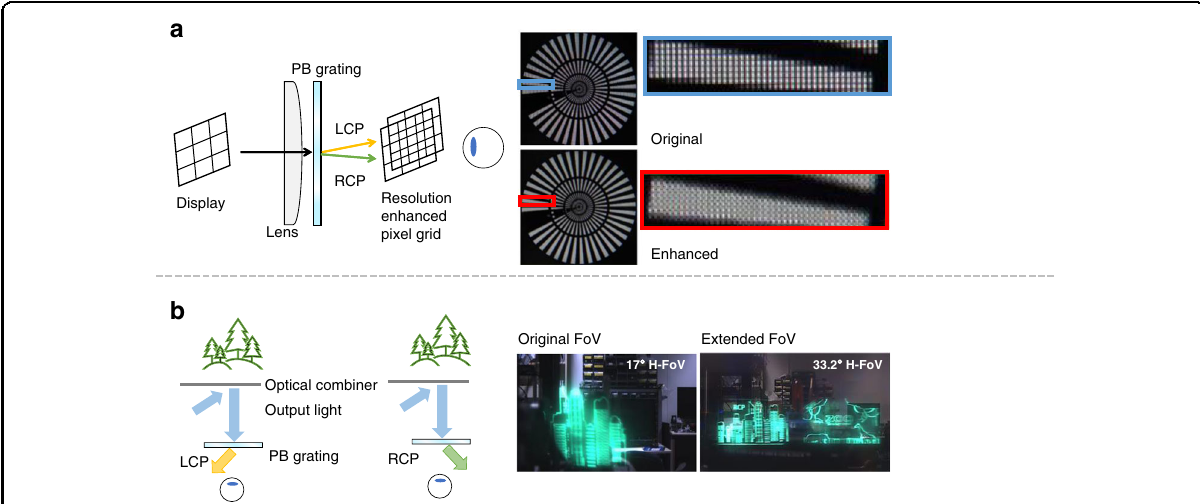
Fig. 10 Applications of transmissive LC grating in AR/VR. a Resolution enhancement system for VR with experimental results. b Polarization multiplexing AR system for extended FoV with experimental results. H-FoV: horizontal fi eld of view. Reprinted from a ref. 171 with permission from The Optical Society and b ref. 173 with permission from The Optical